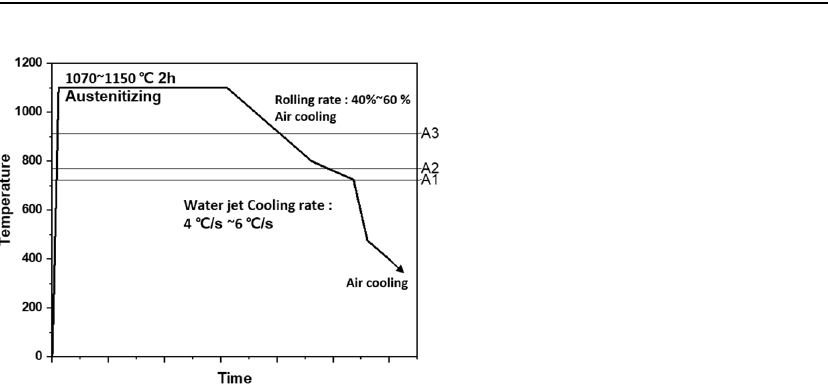
Figure 1. Schematic diagram of the manufacturing conditions of the present thick steel plate. Table 1. Chemical composition (wt%) of the thick steel plate.